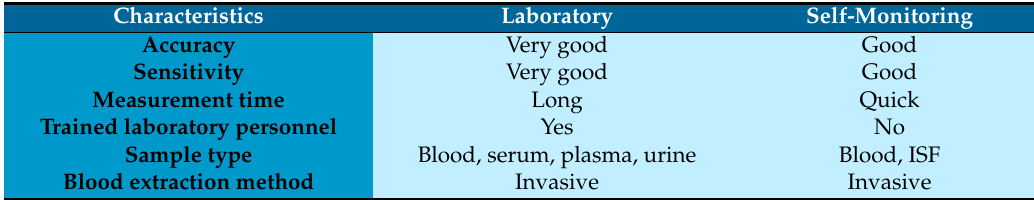
Table 2. Comparison between laboratory and self-monitoring